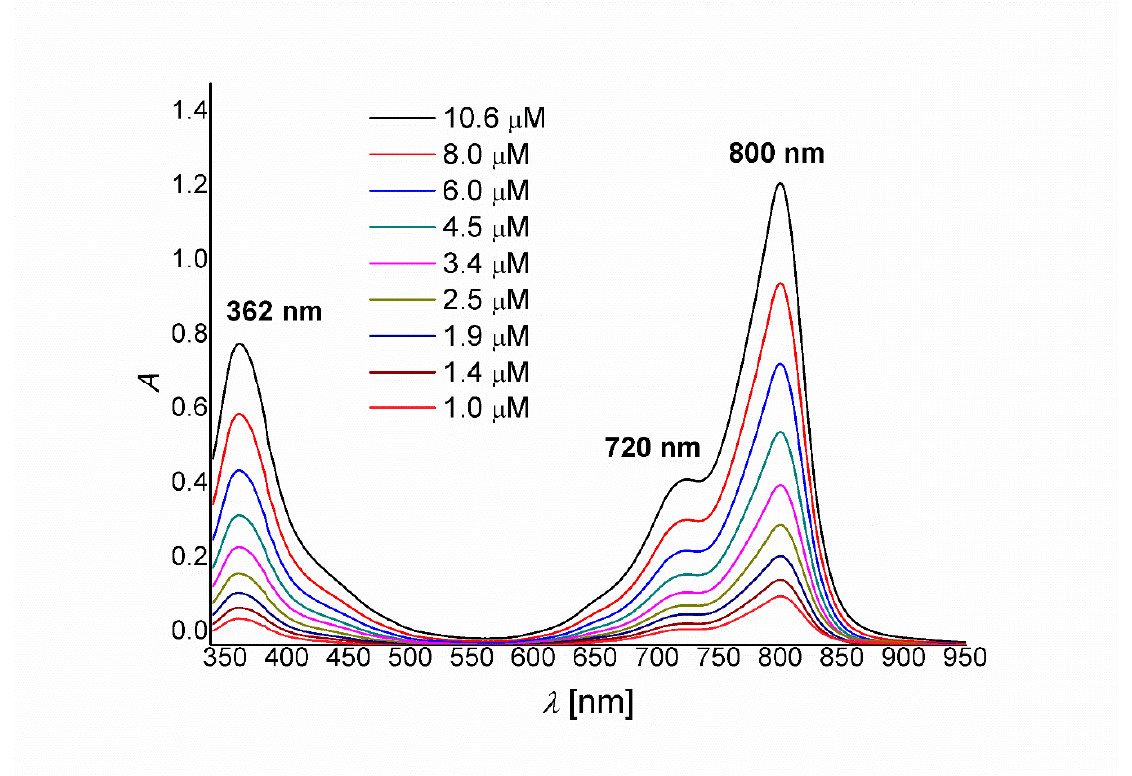
Figure 2. UV–Vis spectra of annulenocyanine 10 in DMF.